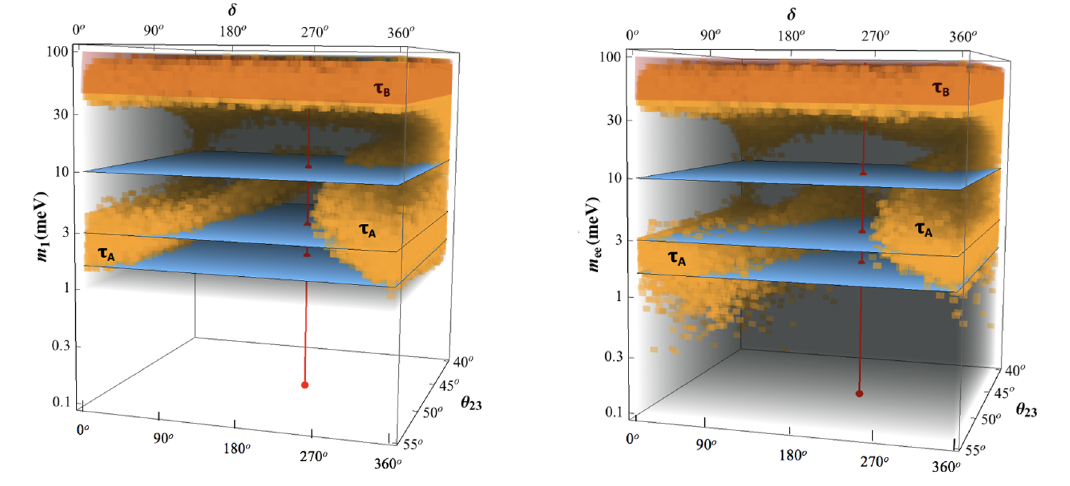
Figure 1 . Scatter plots in the space ( (cid:14); (cid:18) 23 ; m 1 ) (left panel) and ( (cid:14); (cid:18) 23 ; m ee ) (right panel) for (cid:11) 2 = 5 and 0 (cid:20) (cid:18) L (cid:20) (cid:18) CKM . The red vertical axis indicates best (cid:12)t values for (cid:14) and (cid:18) 23 . The red ij ij shaded regions correspond to m 1 & 43 meV, currently disfavoured by cosmological